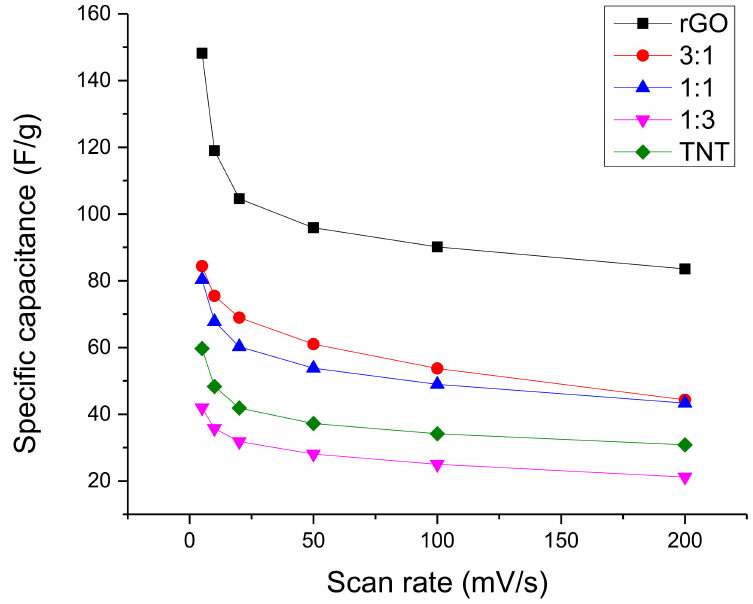
Figure 9. Specific capacitance variation with scan rate of rGO/TiO 2